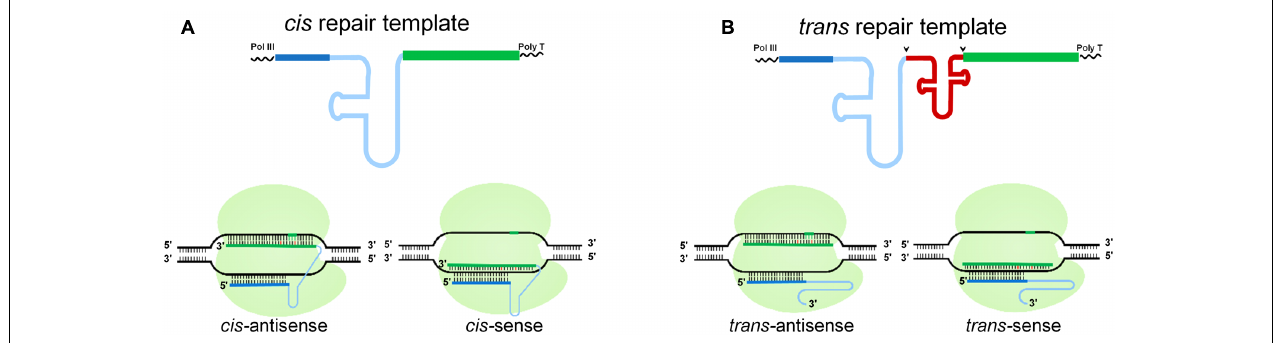
FIGURE 1 | Schematic of RNA-templated DNA Repair. Pol III transcribed RNA was used for the gRNA. (A) In cis repair, the gRNA (blue) is attached directly to the repair template (green). (B) In trans repair, a tRNA (red) separates the gRNA and the repair template, which are processed into two separate RNA molecules; arrows indicate the cleavage positions. Below is a schematic of cis and trans repair at a target locus, where a target-specific gRNA produces a CRISPR/Cas9-mediated DSB that is repaired by HDR. The repair template is in antisense or sense orientation relative to the gRNA sequence. Dark blue line, 20-nt target specific gRNA; light blue line, scaffold RNA; green line, repair template; the small vertical line represents the nucleotide sequence, the green vertical lines represent the PAM sequence, the red vertical lines represent mutations introduced through template-mediated